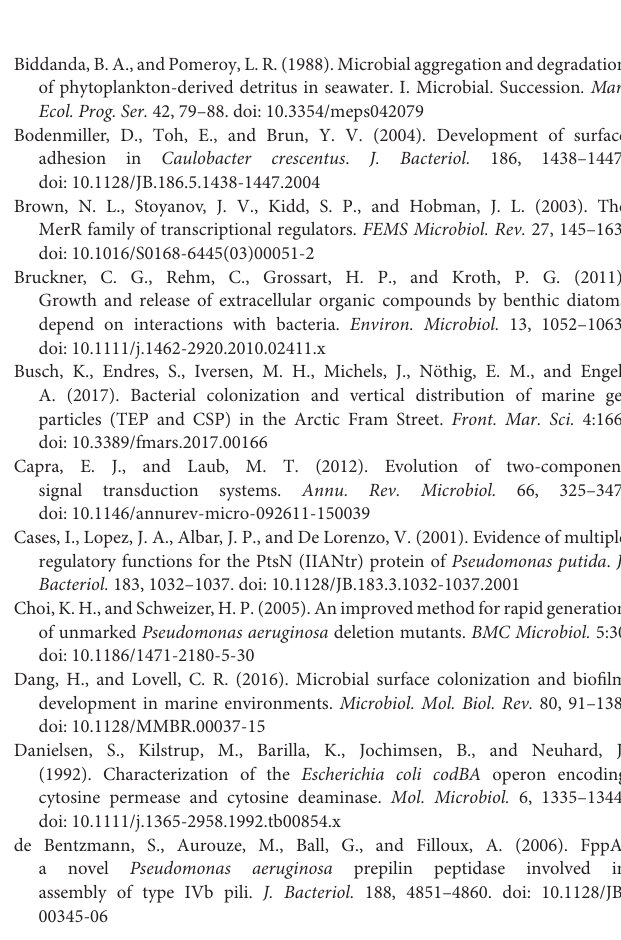
Supplementary Figure 1 | Construction of IVET vector pITM3_pyrB. A promoter-less copy of lacZ from E. coli was ligated into Kpn I-treated pBBR1MCS-4 resulting in plasmid pITM3. Then a promoter-less copy of the genes pyrBC from HP15 was cloned into Hin dIII/ Xho I-treated pITM3 to generate pITM3_pyrB. Supplementary Figure 2 | Bacterial in vitro growth curves of M. adhaerens HP15 wild type, HP15 1 pyrB, and HP15 1 pyrB complemented with 5 µ g ml − 1 of uracil in f/2 GLUT liquid medium and constant shaking at 250